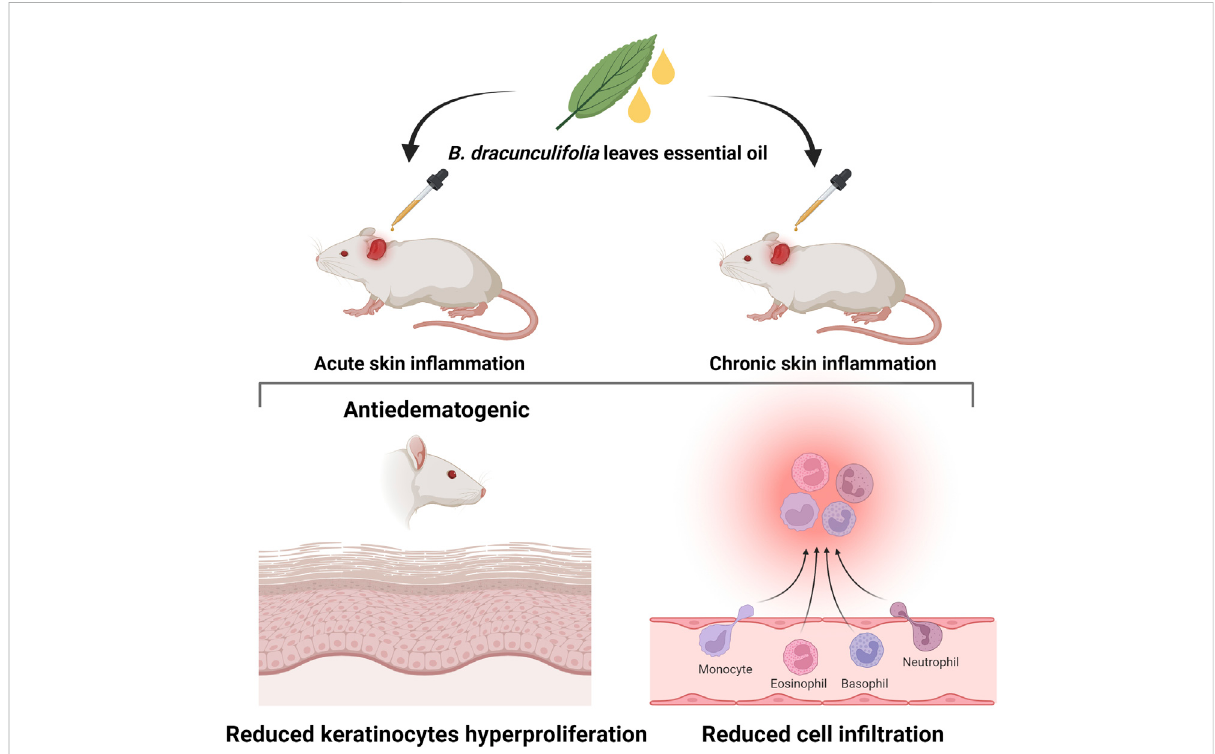
FIGURE 10 Anti-in fl ammatory activity of B. dracunculifolia leaves essential oil evaluated in models of skin in fl ammation (Brandenburg et al.,